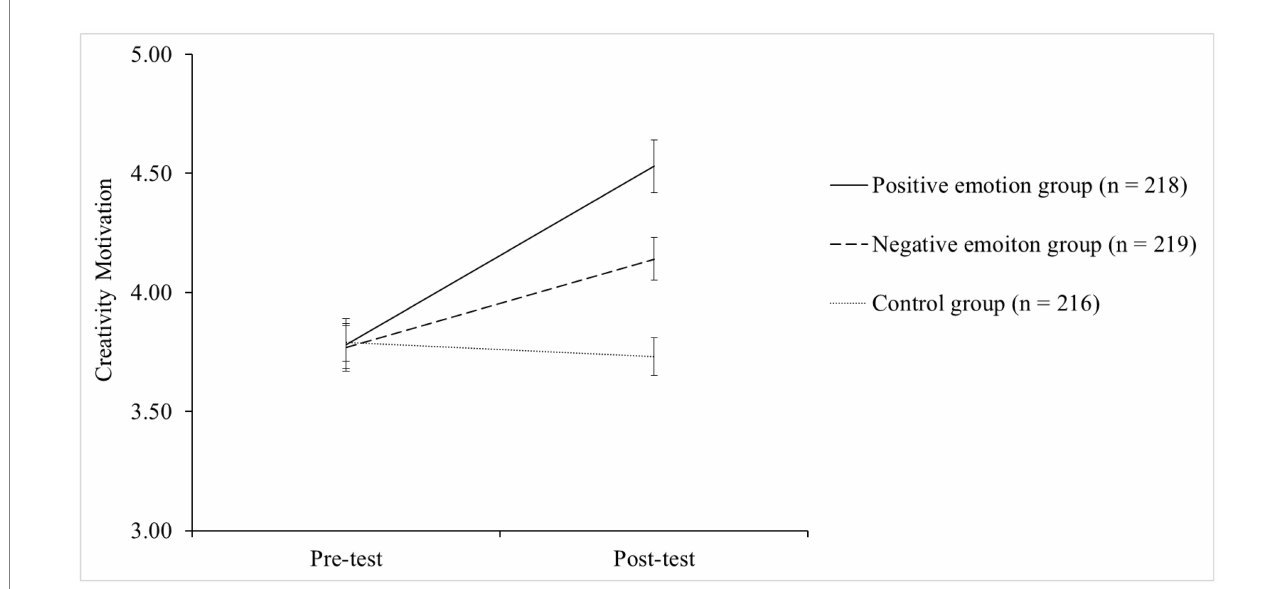
FIGURE 2 Changes in creativity motivation between the pre-and post-test conditions for the three